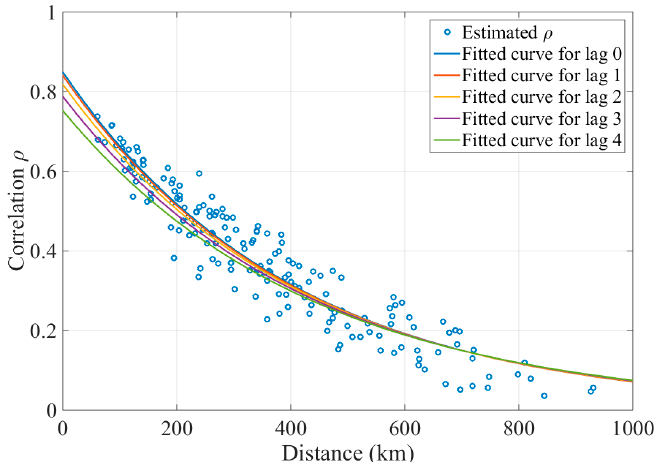
Figure 1. The spatial correlations ρ (i.e., XCFs at lag 0) estimated from z t between wind speed measurement locations plotted against distances between the locations with fitted curves for the spatial correlations at lags 0, 1, 2, 3, and 4.